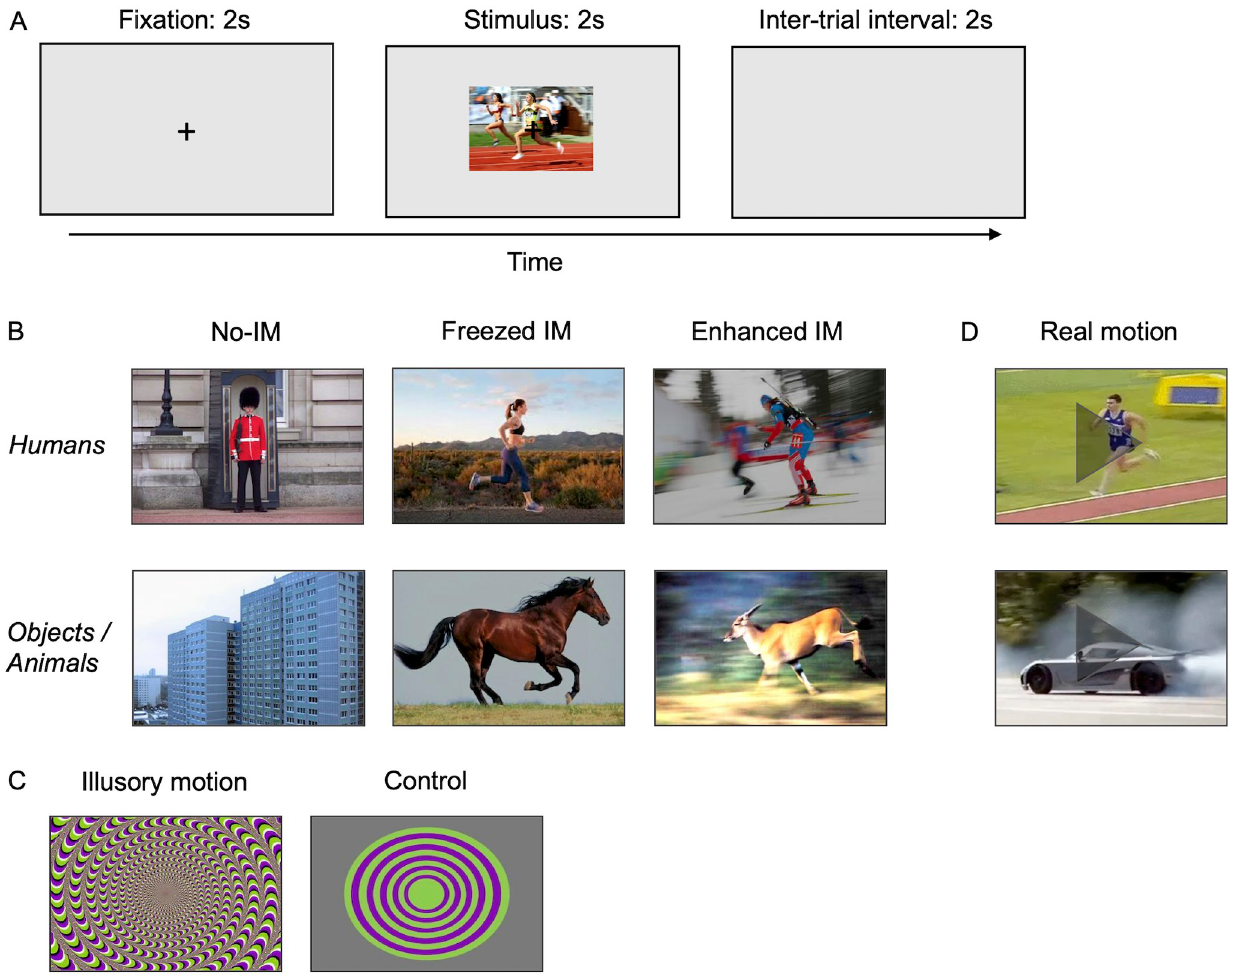
Fig 1. Procedure and stimuli. (A) Schematic of the experimental paradigm. Image shown is n˚ 67 of S1 List. (B) Examples of photos representing different motion categories and content. Images (from left to right) are n˚ 44, 59, 63, 4, 18, and 22 of S1 List. (C) Example of motion illusion (n˚ 88 of S1 List) and its control image. (D) Examples of movies of animated and inanimate subjects, represented here with a single frame. Images (from up to down) are extracted from movies n˚ 76 and 35 of S1 List. Images shown are copyright-free. All experimental stimuli, except controls for illusions, were retrieved from Internet (see S1 List for web